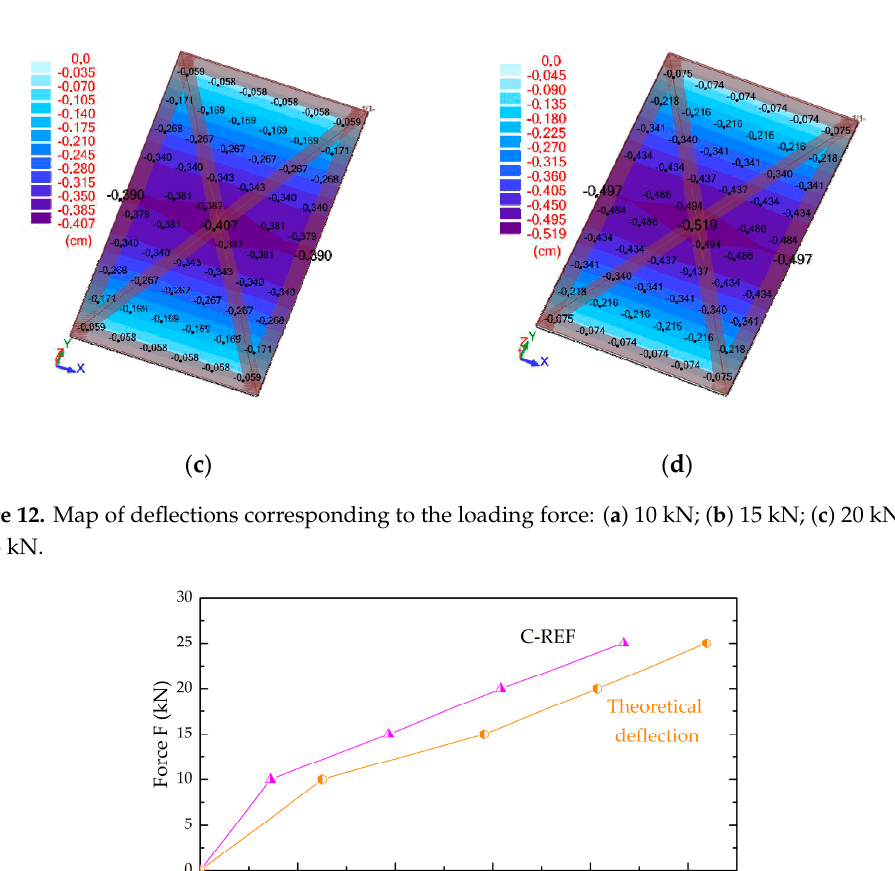
Figure 13. A graph showing a comparative analysis of experimental results (C-REF) and numerical deflection. Table 10. Average deflection for the concrete slabs